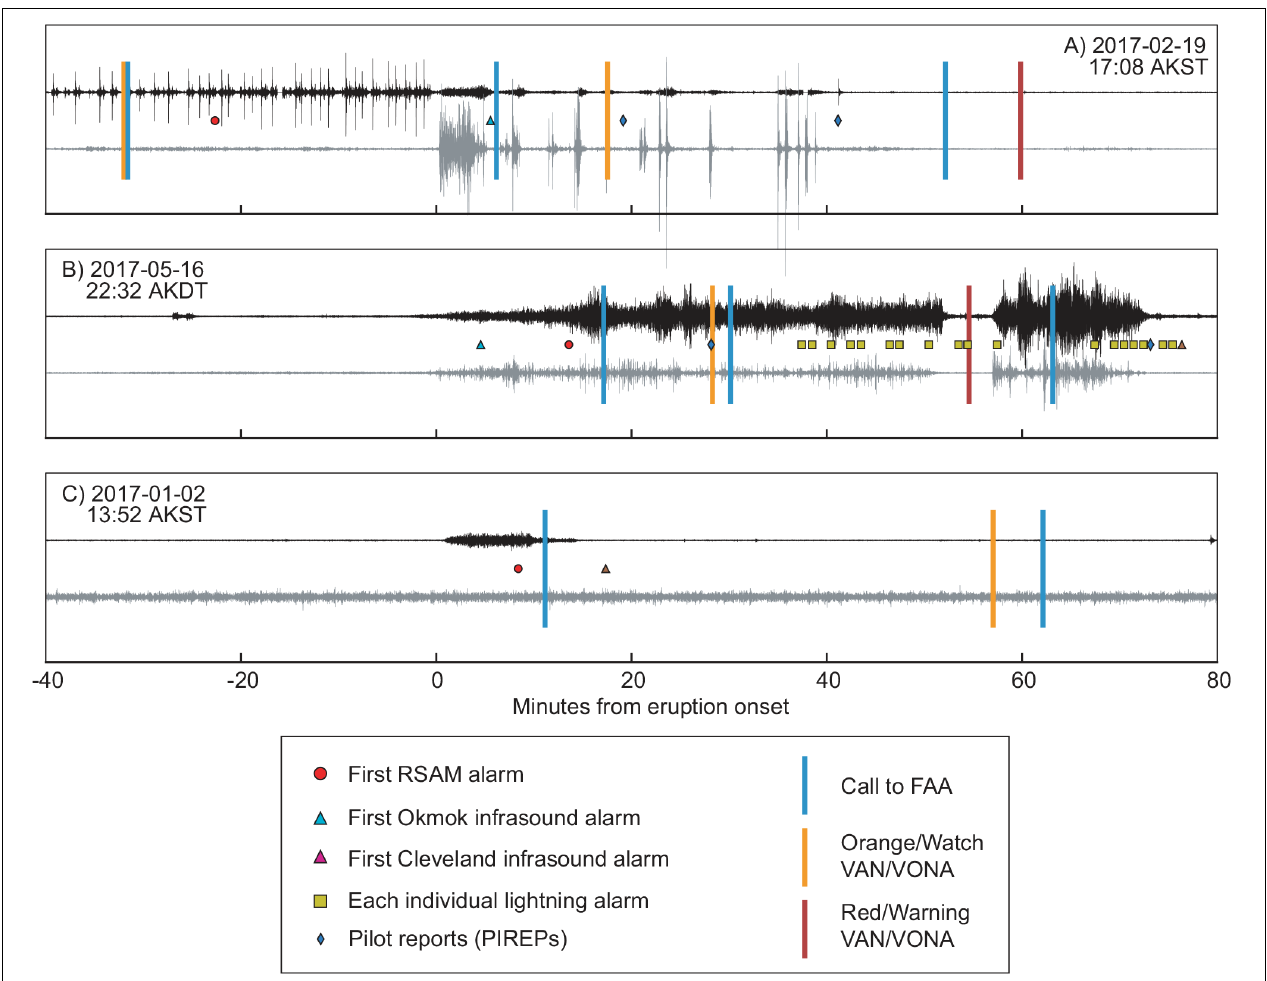
FIGURE 4 | Time series of three characteristic events from the Bogoslof eruptive sequence, showing seismic data from Makushin stations MAPS (black line), infrasound from Okmok (gray line), timing of alarms and data receipt (colored symbols), and timing of warnings issued (colored vertical lines). (A) Event 36, February 19, 2017. This event is an example where precursory data allowed us to issue warnings prior to explosive event onset. (B) Event 39, May 16, 2017. This event was detected in multiple real-time data streams and was an example of a significant ash-producing event that was fairly easy to characterize. (C) Event 14 on January 2, 2017, is an example of a short explosion that was detected in seismic and infrasound data only. The initial call to FAA was fairly rapid, but lack of data resulted in difficulty characterizing the event’s magnitude and led to a delay in issuing a written